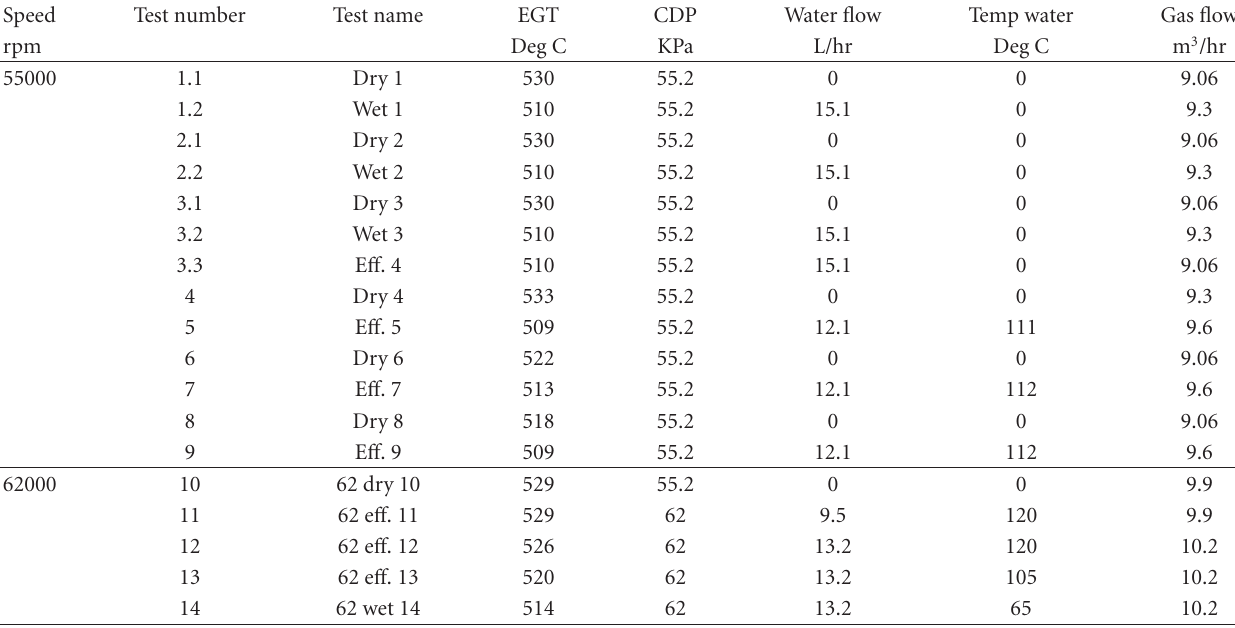
Table 1: Test operating points.